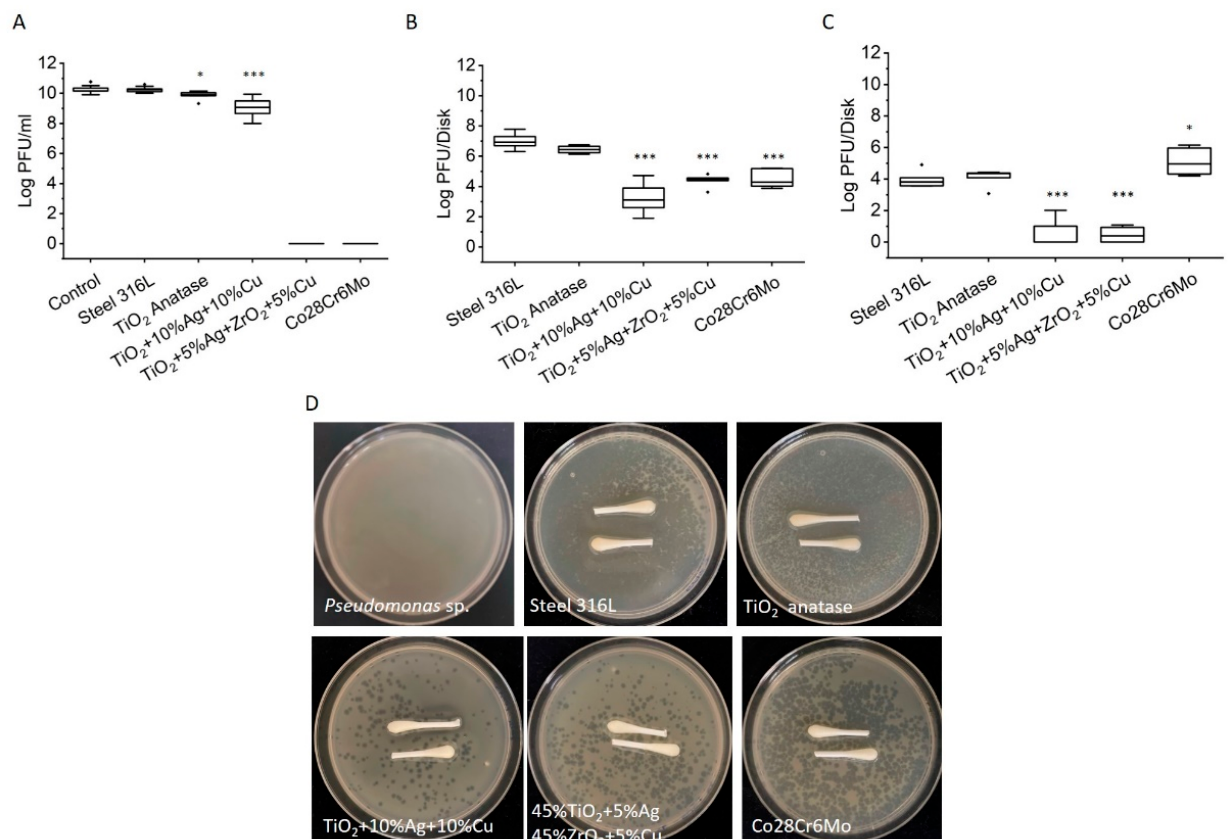
Figure 4. Strongly and weakly attached viruses to ceramic and metal surfaces. Five-digit summary display (minimum, first quartile, median, third quartile, maximum). The circles illustrate the outliers. ( A ) Infective viruses suspended in liquid droplets on disk surfaces; ( B ) weakly attached infective viruses in contact with the disk surfaces; ( C ) strongly attached infective viruses. One asterisk designates p < 0.05, and three asterisks p < 0.001 significance. ( D ) residual infective viruses on swabs. When no virus particles were present on swabs, Pseudomonas sp. could grow and form confluent biofilms on agar plates. When residual viruses were present on swabs, a clear zone of no bacterial growth or individual plaques scattered around the plate were visible.